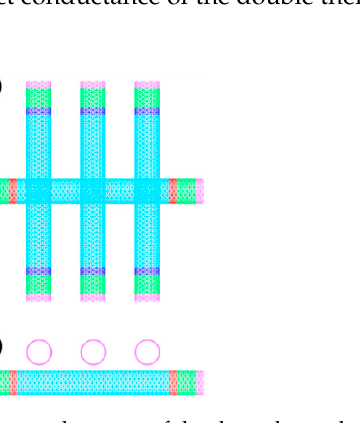
Figure 7. Calculation model for the contact conductance of the three thermal contacts: ( a ) aerial view; ( b ) front view.